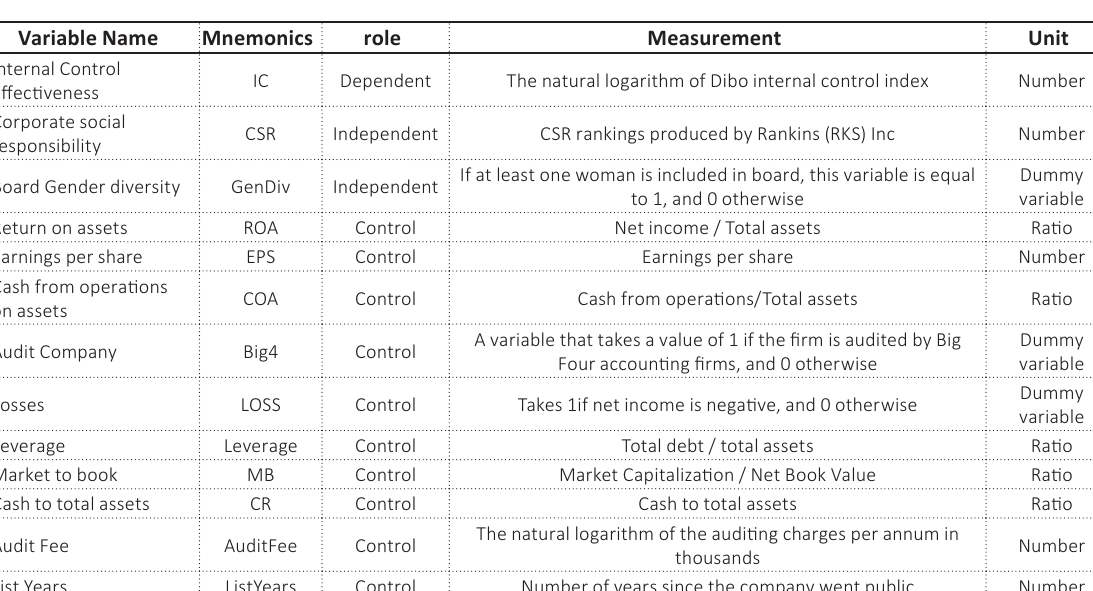
Table 1. Description of variables used in the